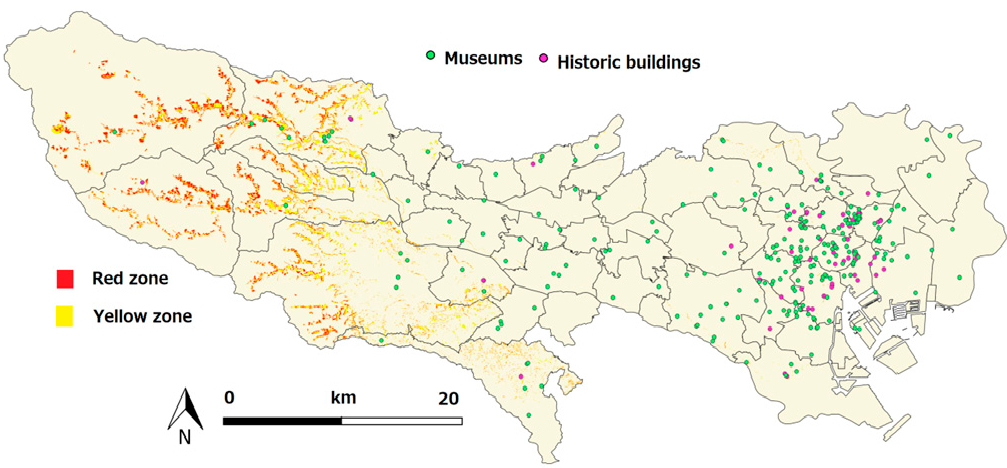
Figure 9. Sediment disaster map of the Tokyo area. Red Zone where slopes can collapse and damage buildings and threaten lives. Yellow Zone where steep slopes can collapse, risking injury or life. Source: National Land Numerical Information (https://nlftp.mlit.go.jp/ [2] ).